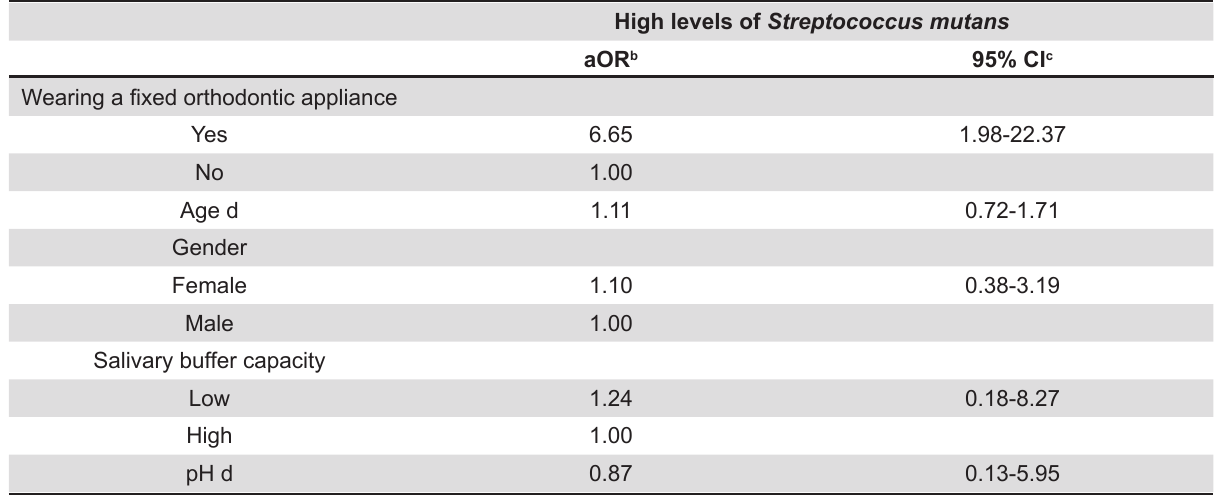
Table 2- Risk factors for high levels of Streptococcus mutans after a 6-month follow-up period